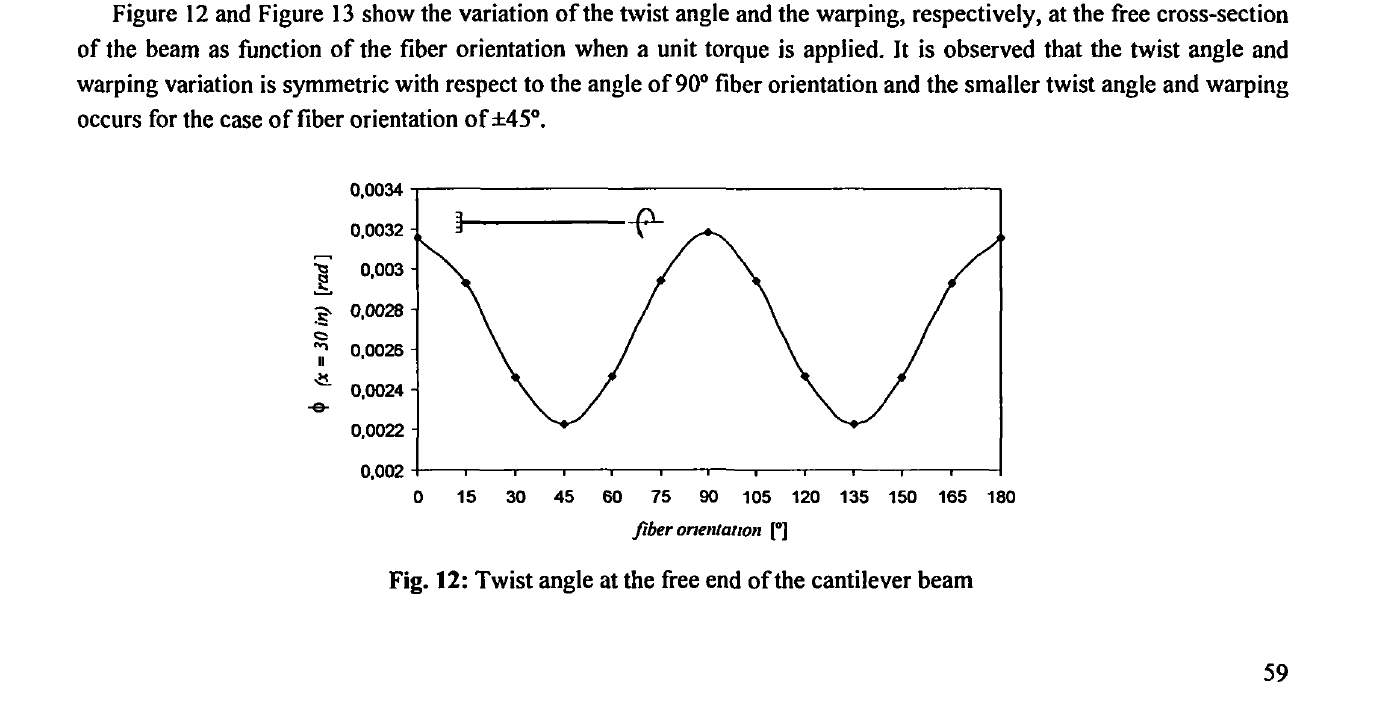
Fig. 12: Twist angle at the free end of the cantilever